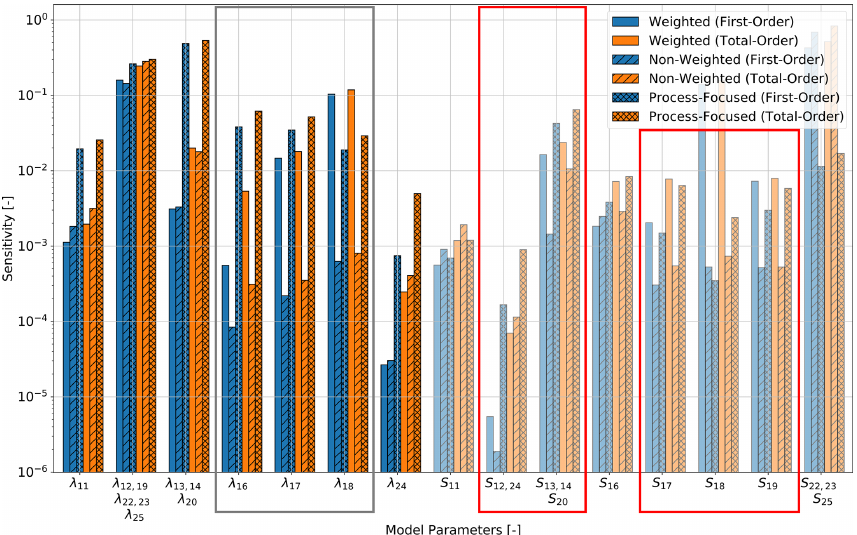
Figure 13. Sensitivity analysis of the upper crust with different weighting schemes of the hierarchical global sensitivity analysis for the General-Focus Alps model. For the Layer IDs and symbols, please refer to Table